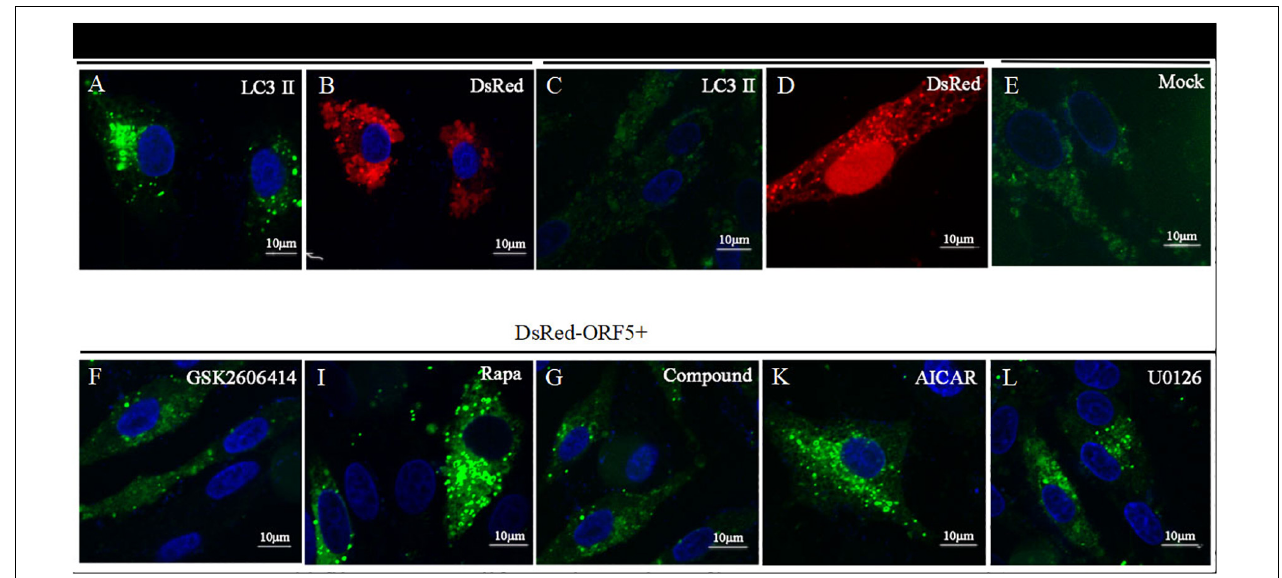
FIGURE 6 | Laser confocal microscope detection of point-like aggregation of LC3. LC3 was detected by laser confocal microscope. (A) PK-15 cells were co-transfected with DsRed-ORF5 and EGFP-LC3 for 48 h. (B) PK-15 cells were transfected with DsRed-ORF5. (C) PK-15 cells co-transfected with DsRed-N1 and EGFP-LC3. (D) PK-15 cells were transfected with DsRed-N1. (E) Control group. (F) PK-15 cells were pretreated with GSK2606414, then co-transfected with DsRed-ORF5 and EGFP-LC3. (I) PK-15 cells were pretreated with Rapa, then co-transfected with DsRed-ORF5 and EGFP-LC3. (G) PK-15 cells were pretreated with Compound C, then co-transfected with DsRed-ORF5 and EGFP-LC3. (K) PK-15 cells were pretreated with AICAR, then co-transfected with DsRed-ORF5 and EGFP-LC3. (L) PK-15 cells were pretreated with U0126, then co-transfected with DsRed-ORF5 and EGFP-LC3. ∗ p < 0.05, ∗∗ p <